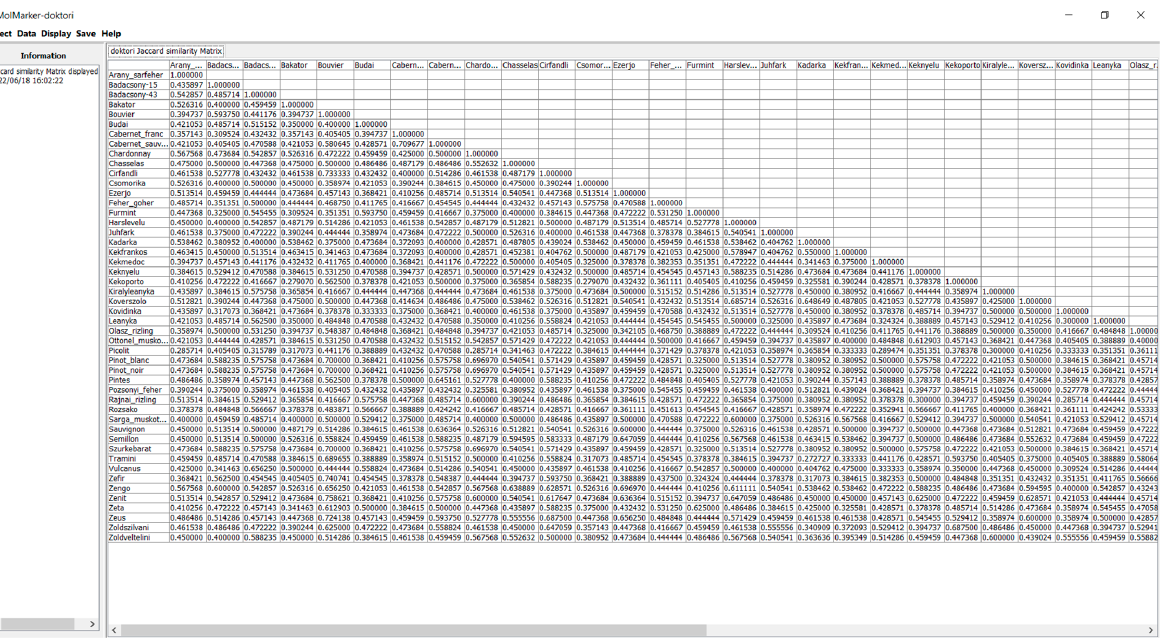
Figure 5. Similarity matrix using Jaccard similarities of SSR data. The first snapshot of relationships among samples is displayed by the UPGMA and Neighbor-Joining methods (Figure 6). As these methods are preceded by other methods, we recommend subjecting the data set to more rigorous analysis with other programs and using MolMarker for data exploration.